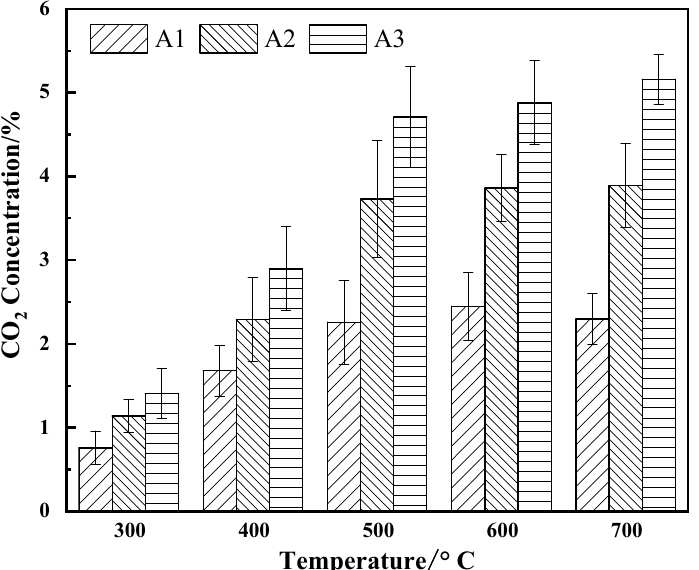
Figure 9. The concentration of CO 2 during thermal desorption of simulated polluted soils under 20% O 2 /N 2 atmosphere at different temperatures. (A1, sample of 1 mL waste oil mixed with 25 g soil; A2, sample of 2 mL waste oil mixed with 25 g soil; A3, sample of 3 mL waste oil mixed with 25 g soil).